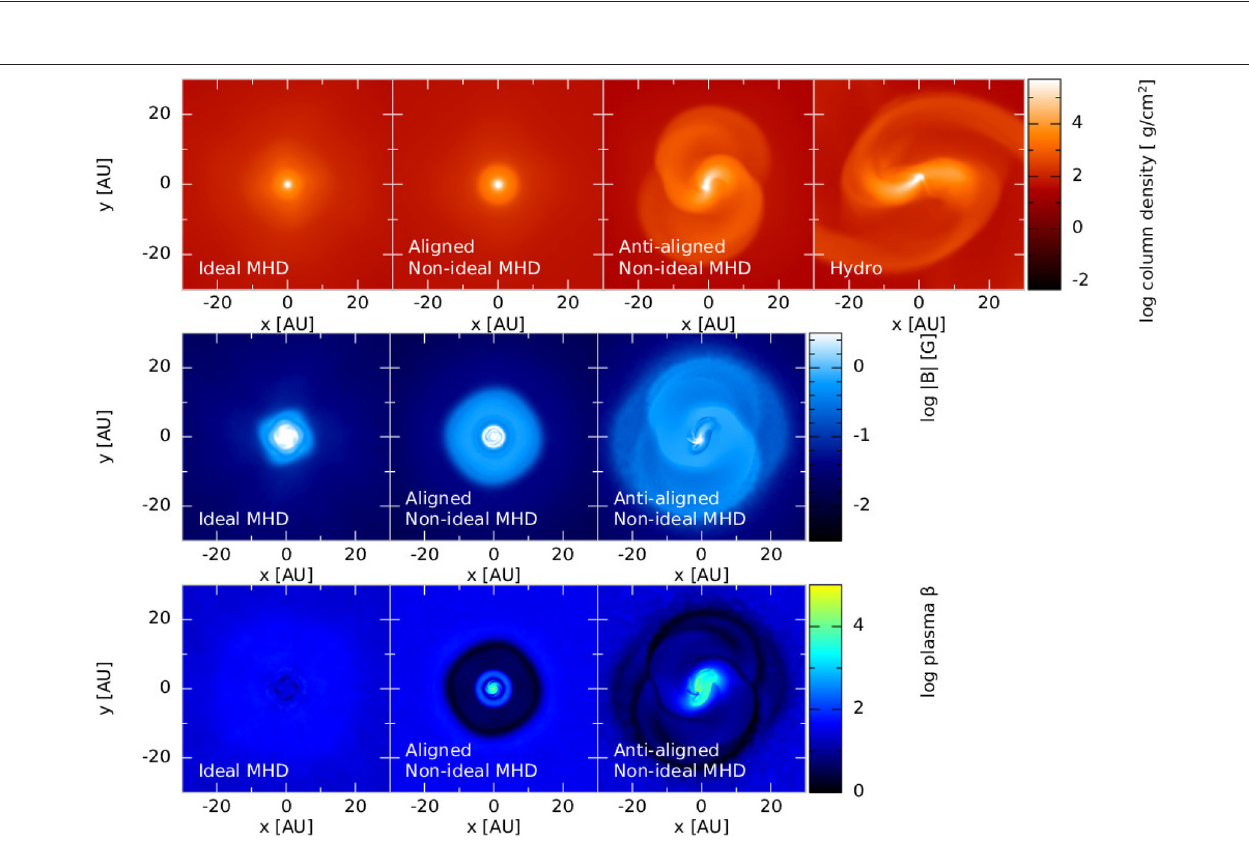
FIGURE 8 | The gas column density (top) , magnetic field strength (middle) and plasma β (bottom) in a slice through the mid-plane of an ideal MHD model, two non-ideal MHD models (Ohmic+ambipolar+Hall; ζ cr = 10 − 17 s − 1 ) with different initial orientations of the magnetic field, and purely hydrodynamics model (top row only). The snapshots are near the end of the first core phase. When the rotation and magnetic field vector are aligned, the non-ideal MHD model is similar to the ideal MHD model with no disc, but when the vectors are anti-aligned, a gravitationally unstable disc forms, similar to the hydrodynamics model. The maximum magnetic field strength is in the disc for the anti-aligned non-ideal model, while it is in the center of the first core for the remaining two models. The disc in the anti-aligned model is supported by gas pressure. The figure is adapted/inspired by Figures 1 and 8 of Wurster et al. (2018c) and Figure 1 of Tsukamoto et al. (2015a) and was created for this publication using the data from Wurster et al.